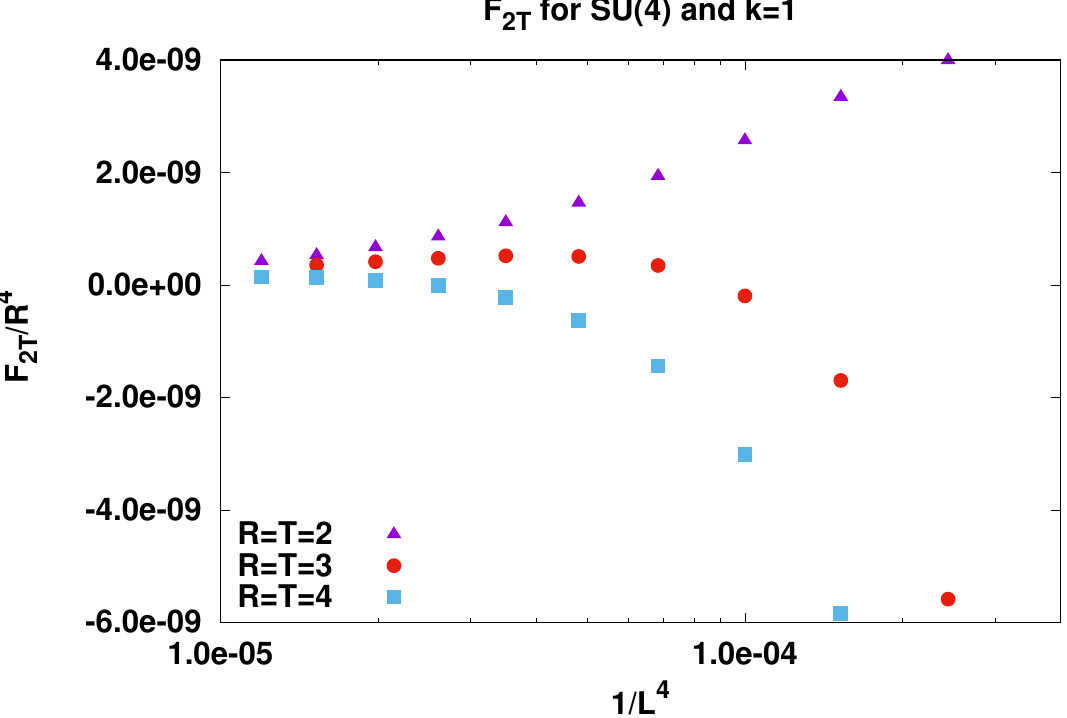
Figure 5. F 2 T divided by R 4 for an R (cid:2) R loop for SU(4) and k = 1 as a function of volume.